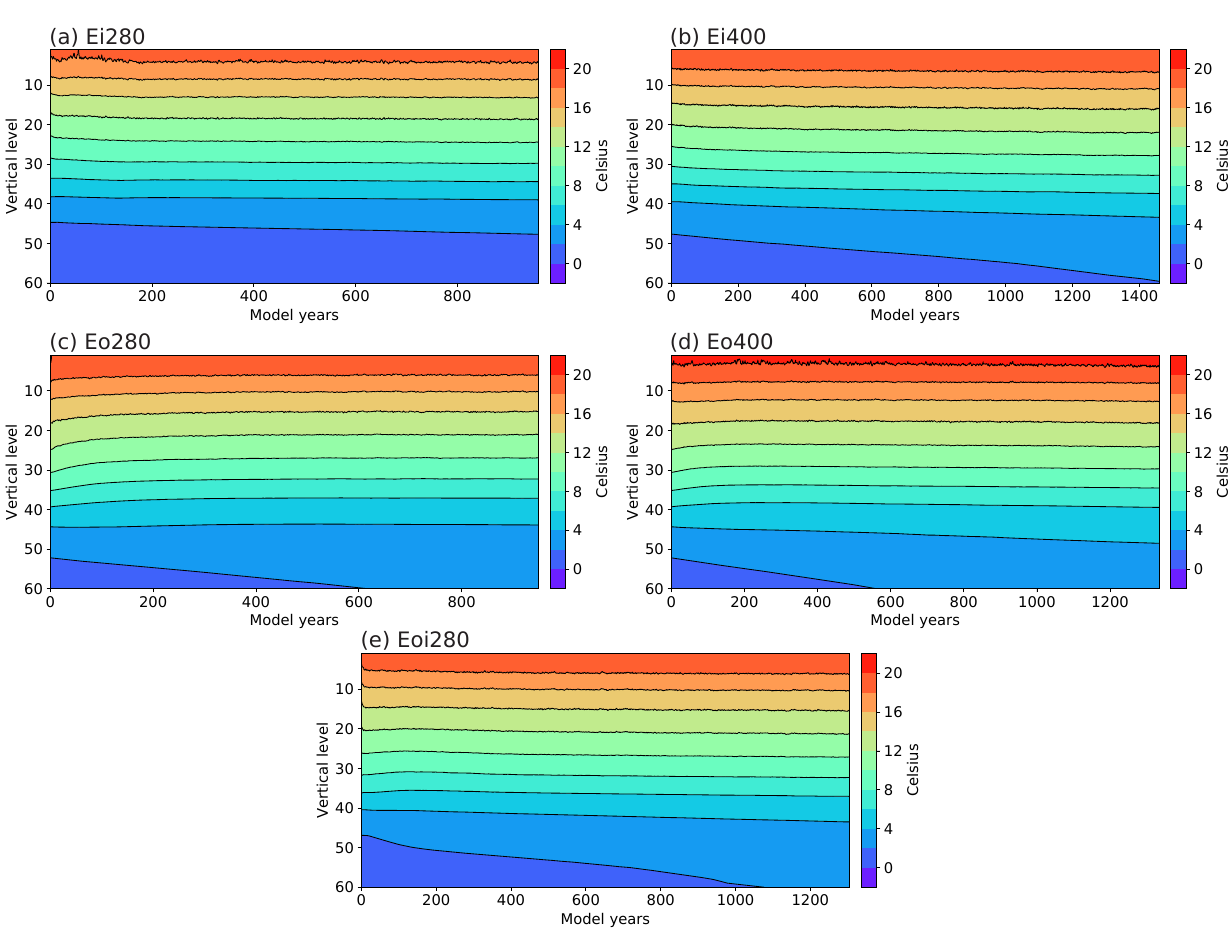
Figure 4. Hovmöller diagrams for the evolution of ocean temperatures as a function of depth in the five sensitivity